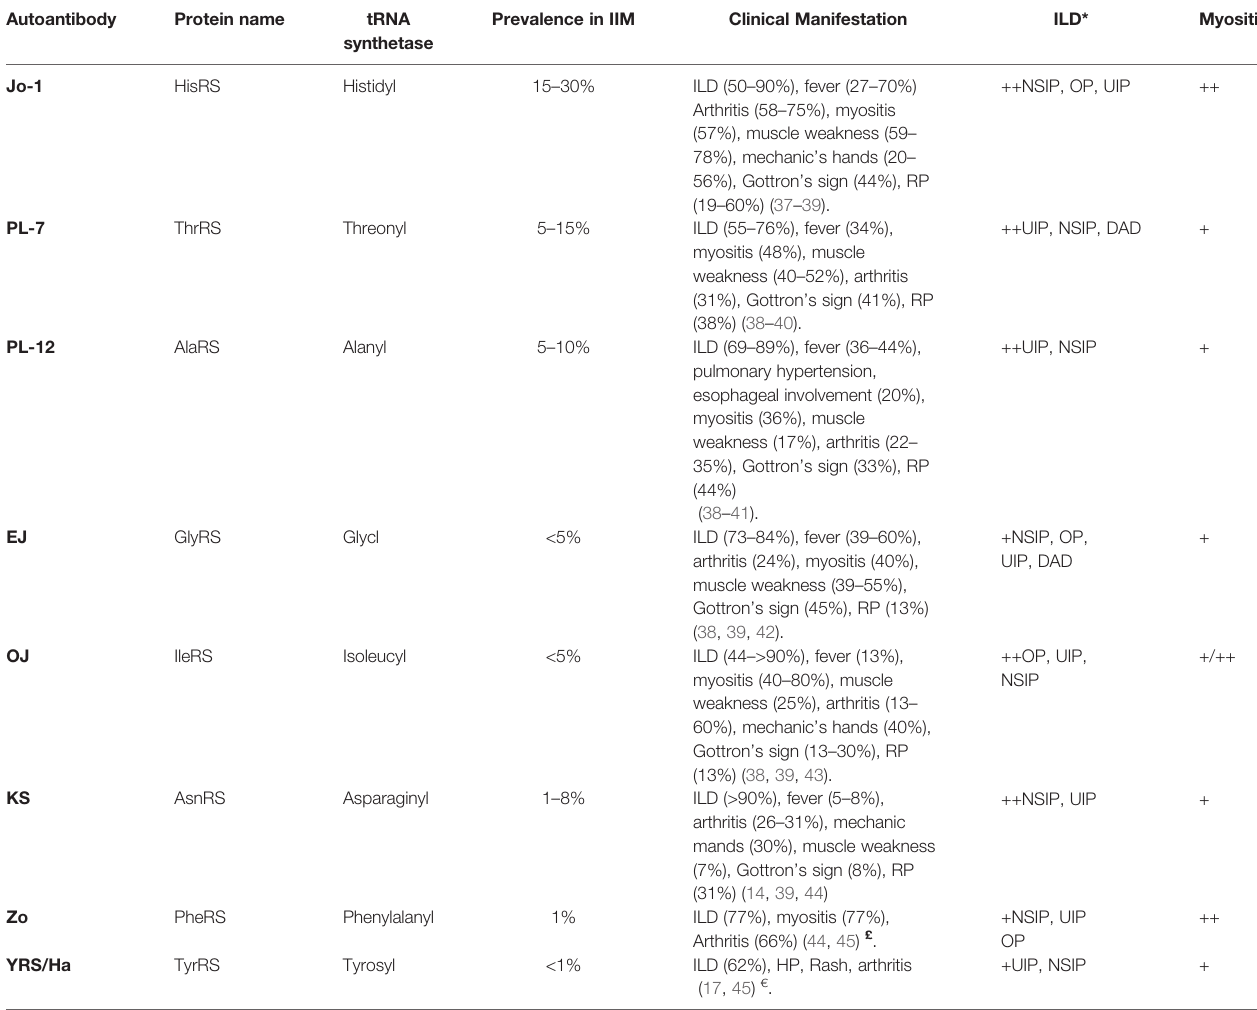
TABLE 2 | Common antisynthetase autoantibodies in